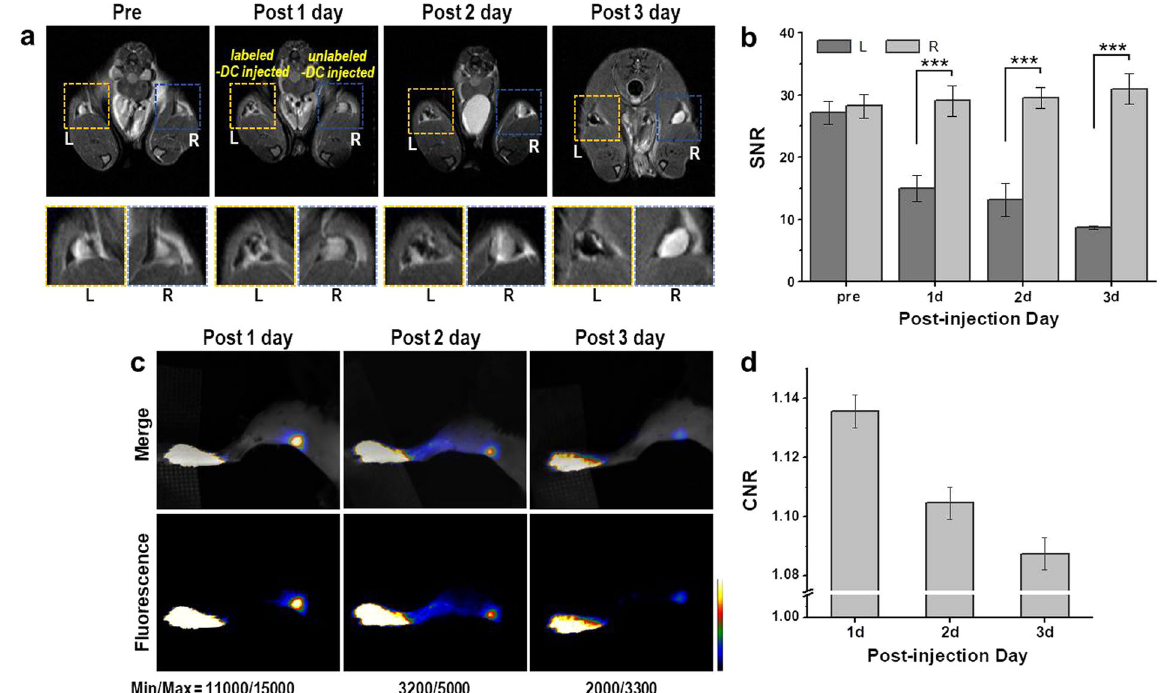
Figure 5. In vivo MR/FL imaging of cells labeled with ICGylated MNPs. ( a ) In vivo T 2 -weighted MR images of mouse popliteal lymph nodes at different times after injection of DCs labeled with ICGylated MNPs (L, left) and unlabeled (R, right) DCs (2 × 10 6 cells). ( b ) Signal-to-noise ratios obtained from MR images of ( a ). ( c ) In vivo NIR fluorescence images of mouse popliteal lymph nodes after injection of the labeled DCs. ( d ) Contrast-to- noise ratio (CNR) values of the lymph nodes obtained from ( c ). *** p <